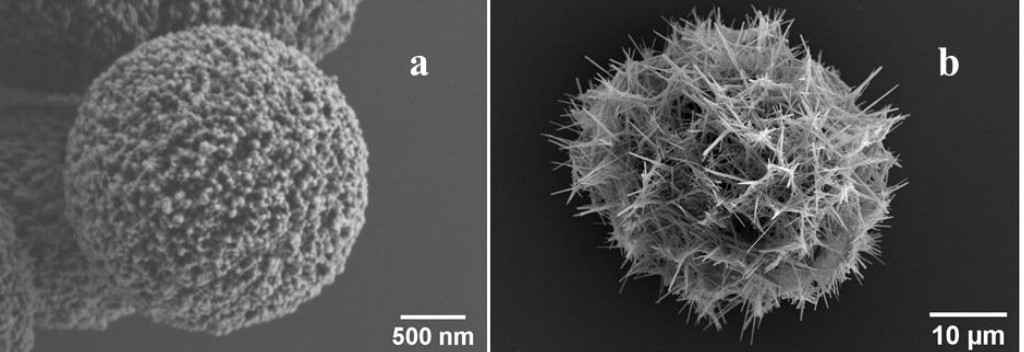
Figure 6. Kinetics of Luc-CL of neutrophils stimulated by vaterite with adsorbed HSA-MG (5 mg/g CC) before and after 120 Un/mL SOD addition. Microparticle concentration: 1 mg/mL; neutrophil concentration: 0.5 × 10 6 cells/mL .